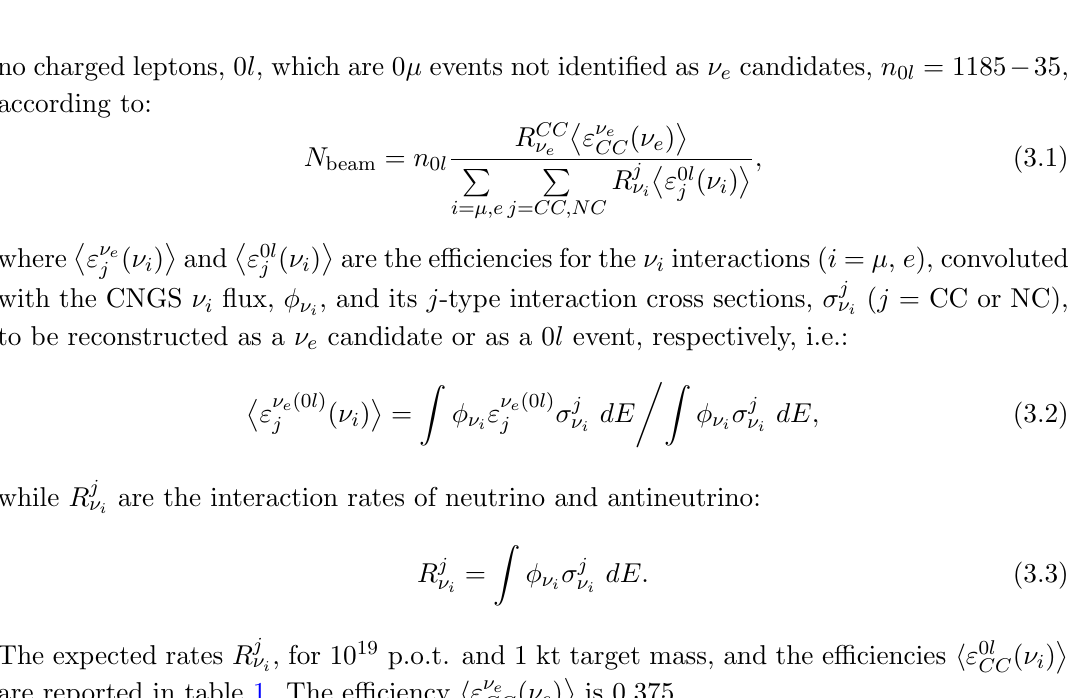
Table 1 . Expected rates of neutrino and antineutrino of type i interacting by the j process normalized to 10 19 p.o.t. and 1 kt target mass. In brackets the e(cid:14)ciencies of (cid:23) i interactions, convoluted with the CNGS (cid:23) i (cid:13)ux and its j -type interaction cross sections, to be reconstructed as a 0 l